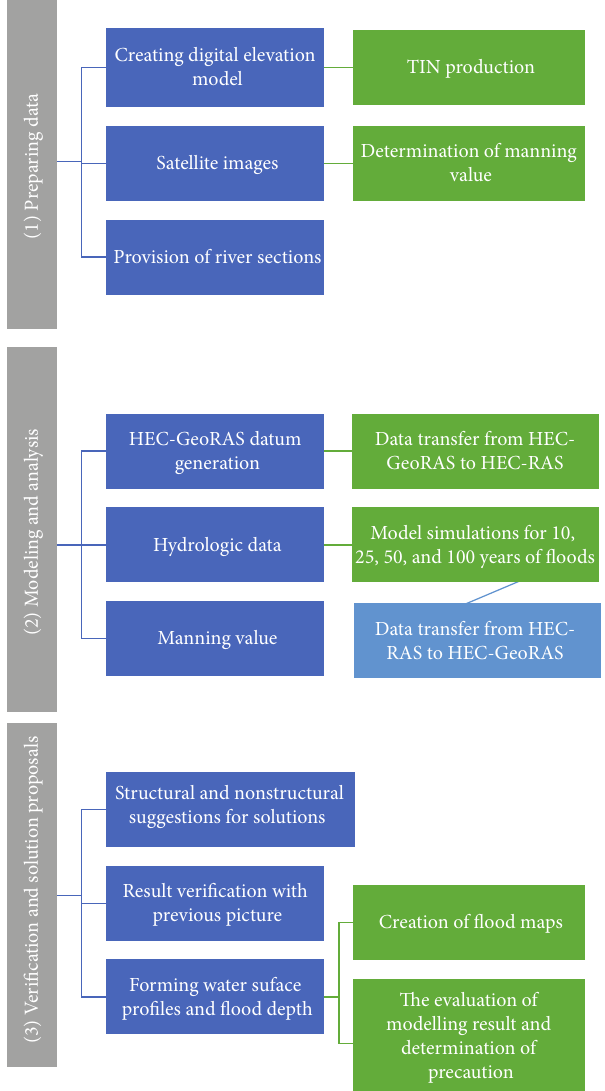
Figure 2: Flow chart of